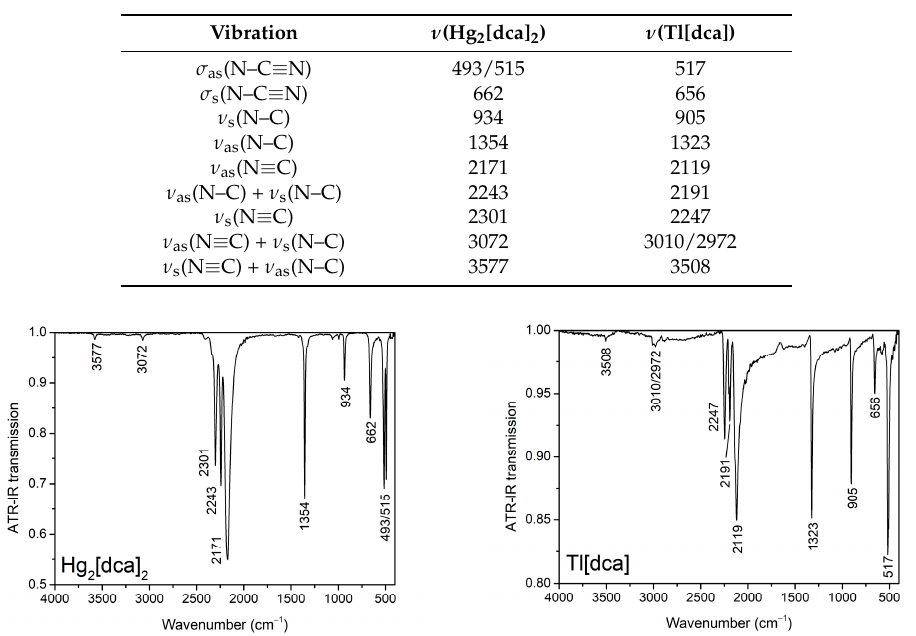
Table 3. IR data of Hg 2 [dca] 2 and Tl[dca]. All numbers are given in cm − 1 .